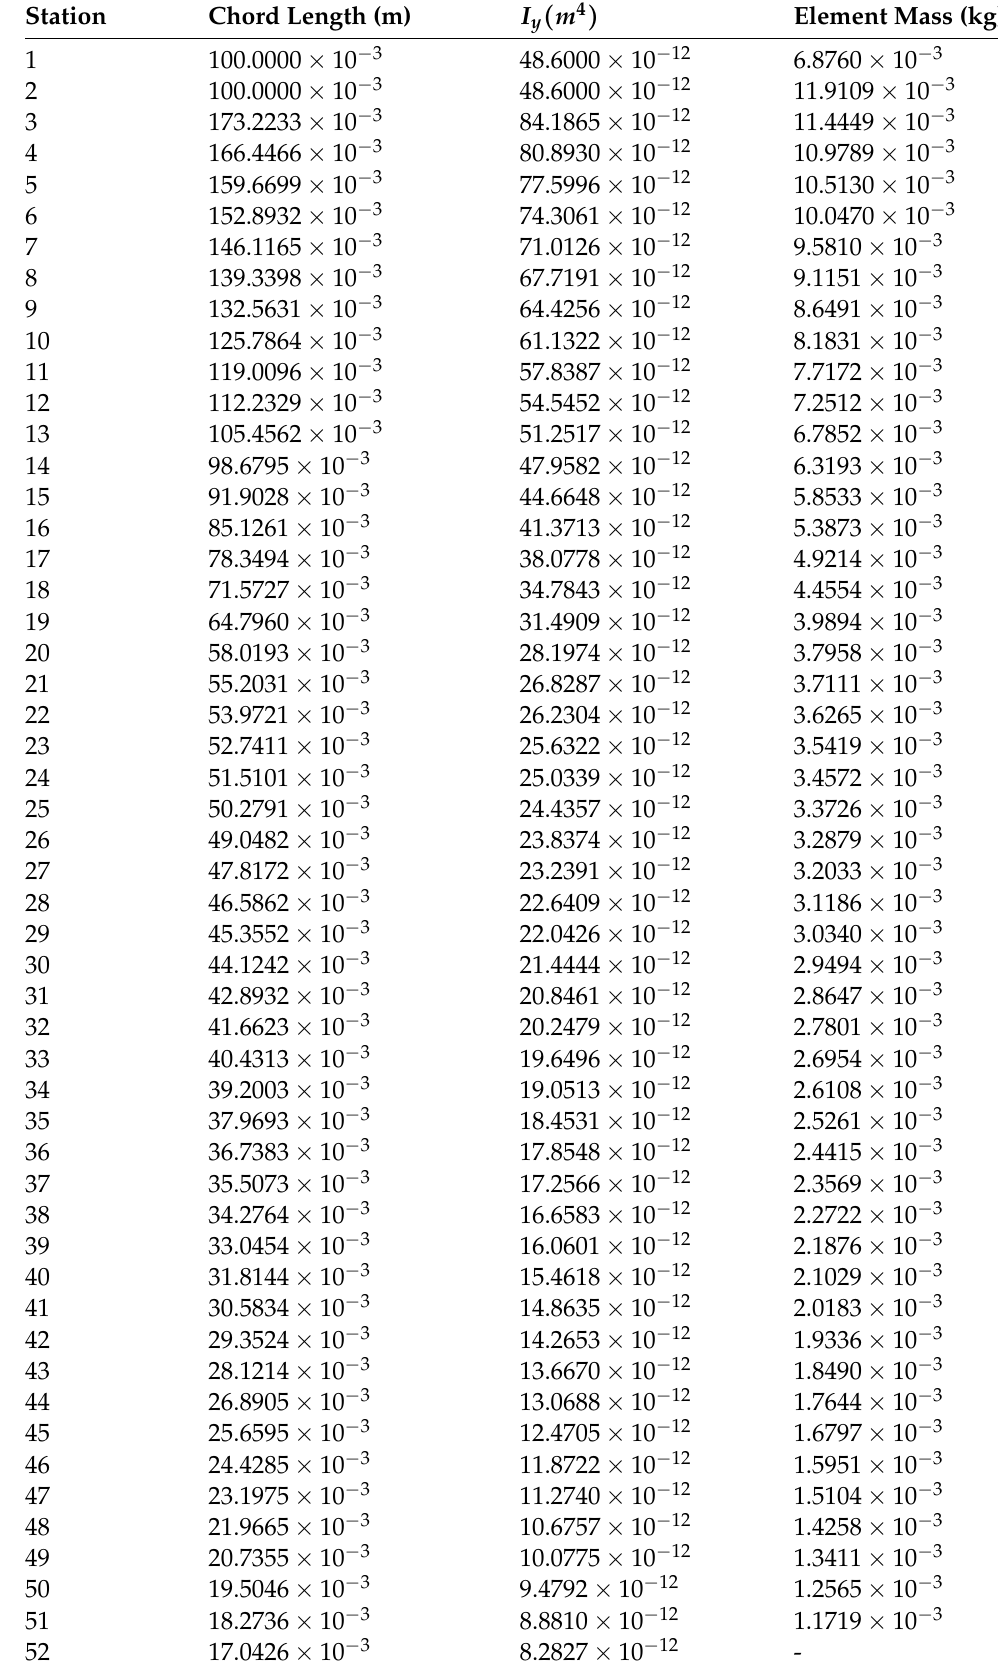
Table 4. Wing spar model beam